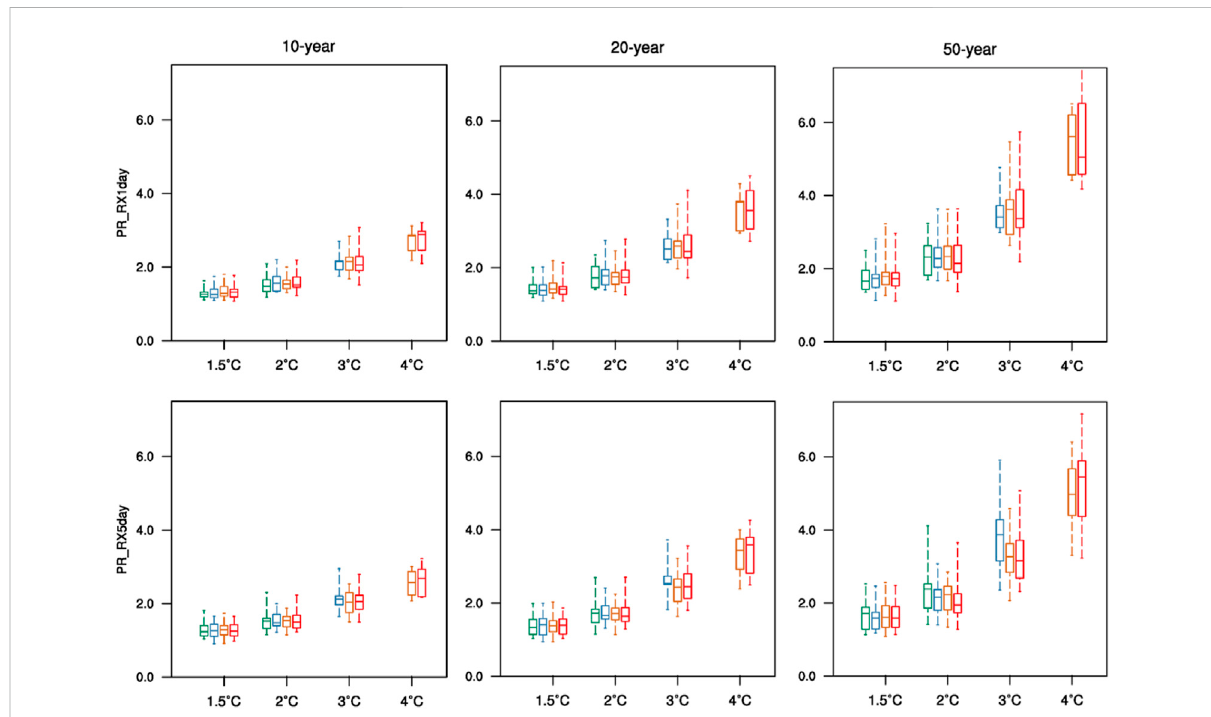
FIGURE 3 Box-and-whisker plots of the PRs of occurrence of 10-year, 20-year, and 50-year events averaged over China at the 1.5 – 4.0 ° C warming level under different scenarios. The green, blue, orange, and red boxes denote the PRs under the SSP1-2.6, SSP2-4.5, SSP3-7.0 and SSP5-8.5 scenarios,